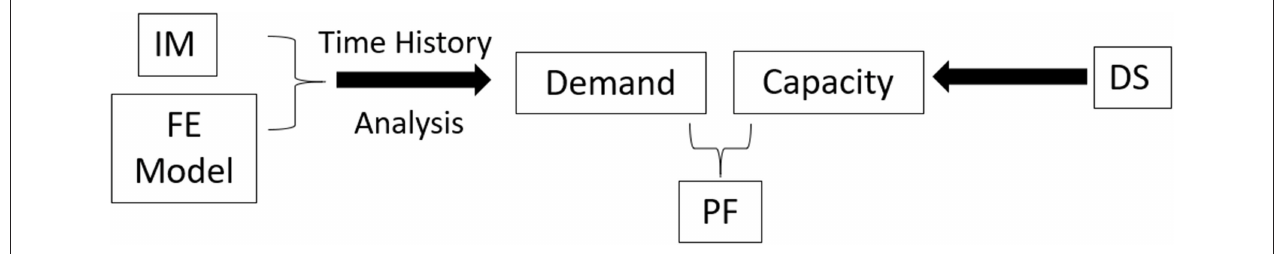
FIGURE 2 | Seismic vulnerability assessment